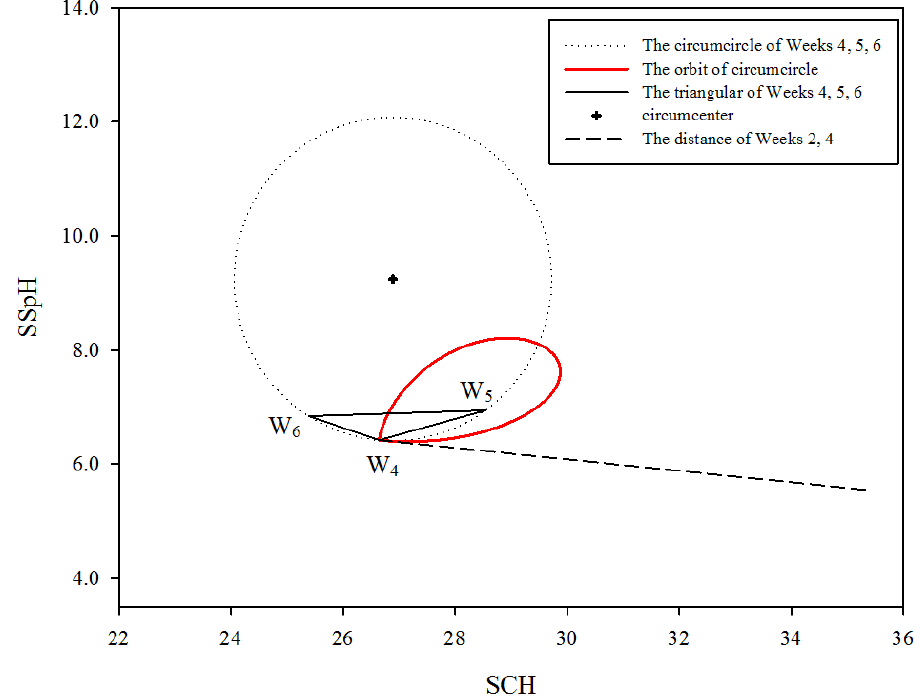
Figure 2. SNS performance: a red spindle-shaped closed